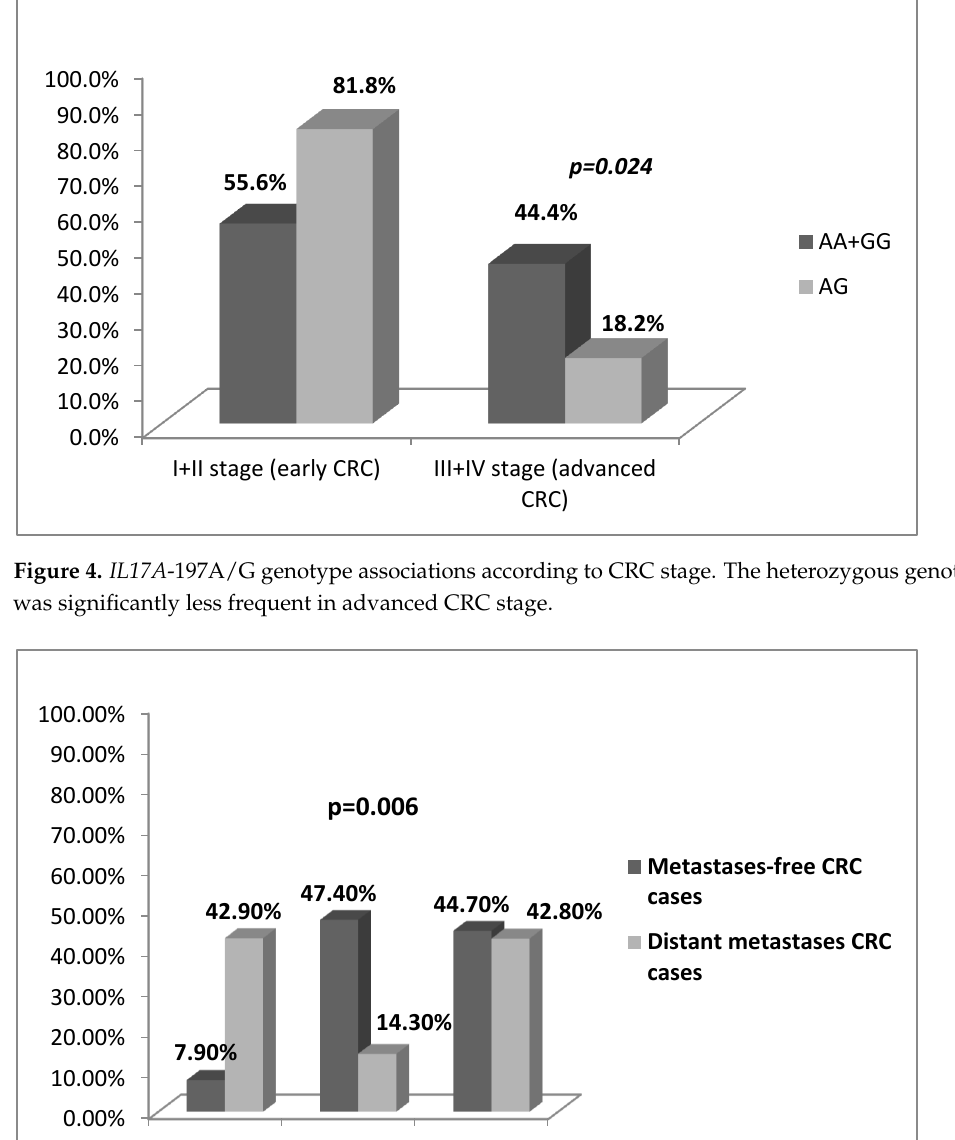
8 of 16 Figure 3. Association of IL17A -197 A/G genotypes and average age of diagnosis among CRC pa- tients. A tendency for lower age at diagnosis was observed for the carriers of the homozygous A/A-